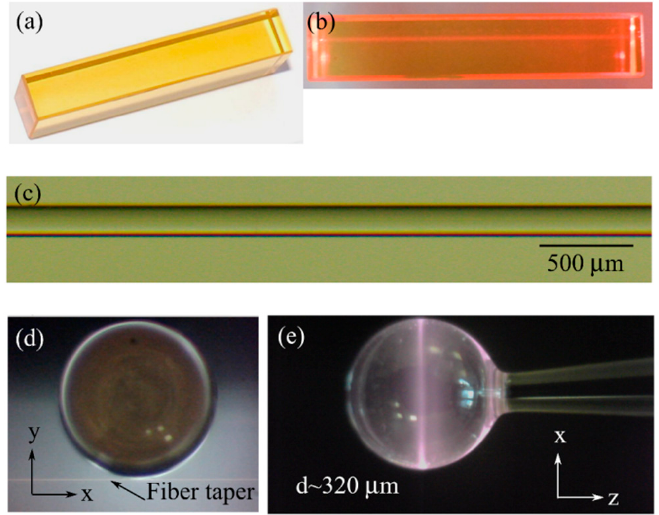
Figure 4. ( a ) A photography of the polished thulium-doped tellurite glass parallelepiped with dimensions of 8 × 8 × 44 mm. ( b ) A photography of He-Ne laser beam in this sample. ( c ) A microphotography of single-index fiber produced from the synthesized glass. ( d , e ) The images of the experimentally produced tellurite glass microsphere in perpendicular planes from two CCD cameras. The coordinate axes in ( d , e ) correspond to the axes in Figure 1.